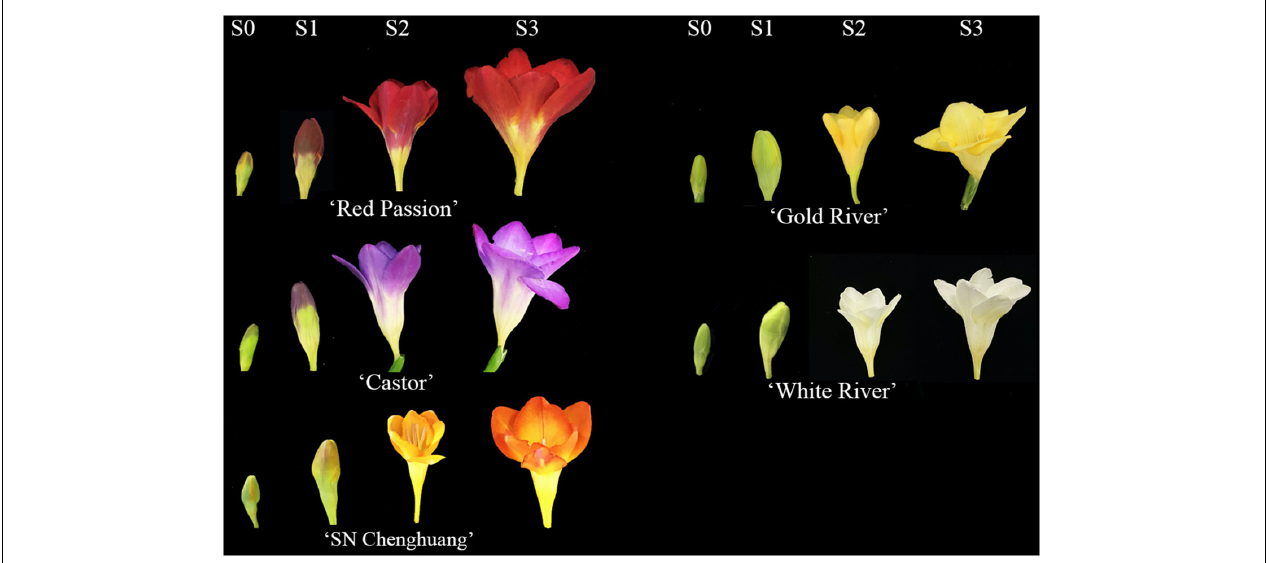
FIGURE 1 | Flower color phenotypes of five Freesia hybrida cultivars at different developmental stages.